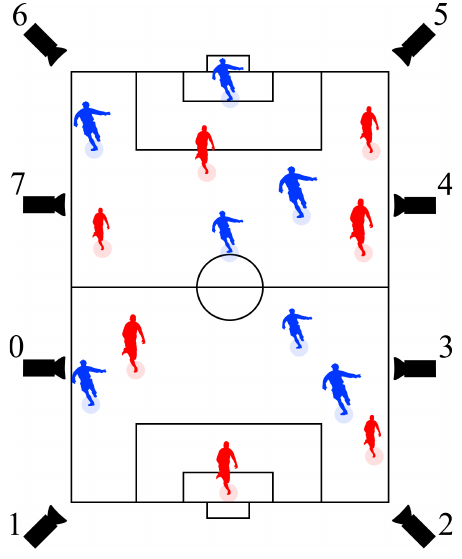
Figure 1. Camera